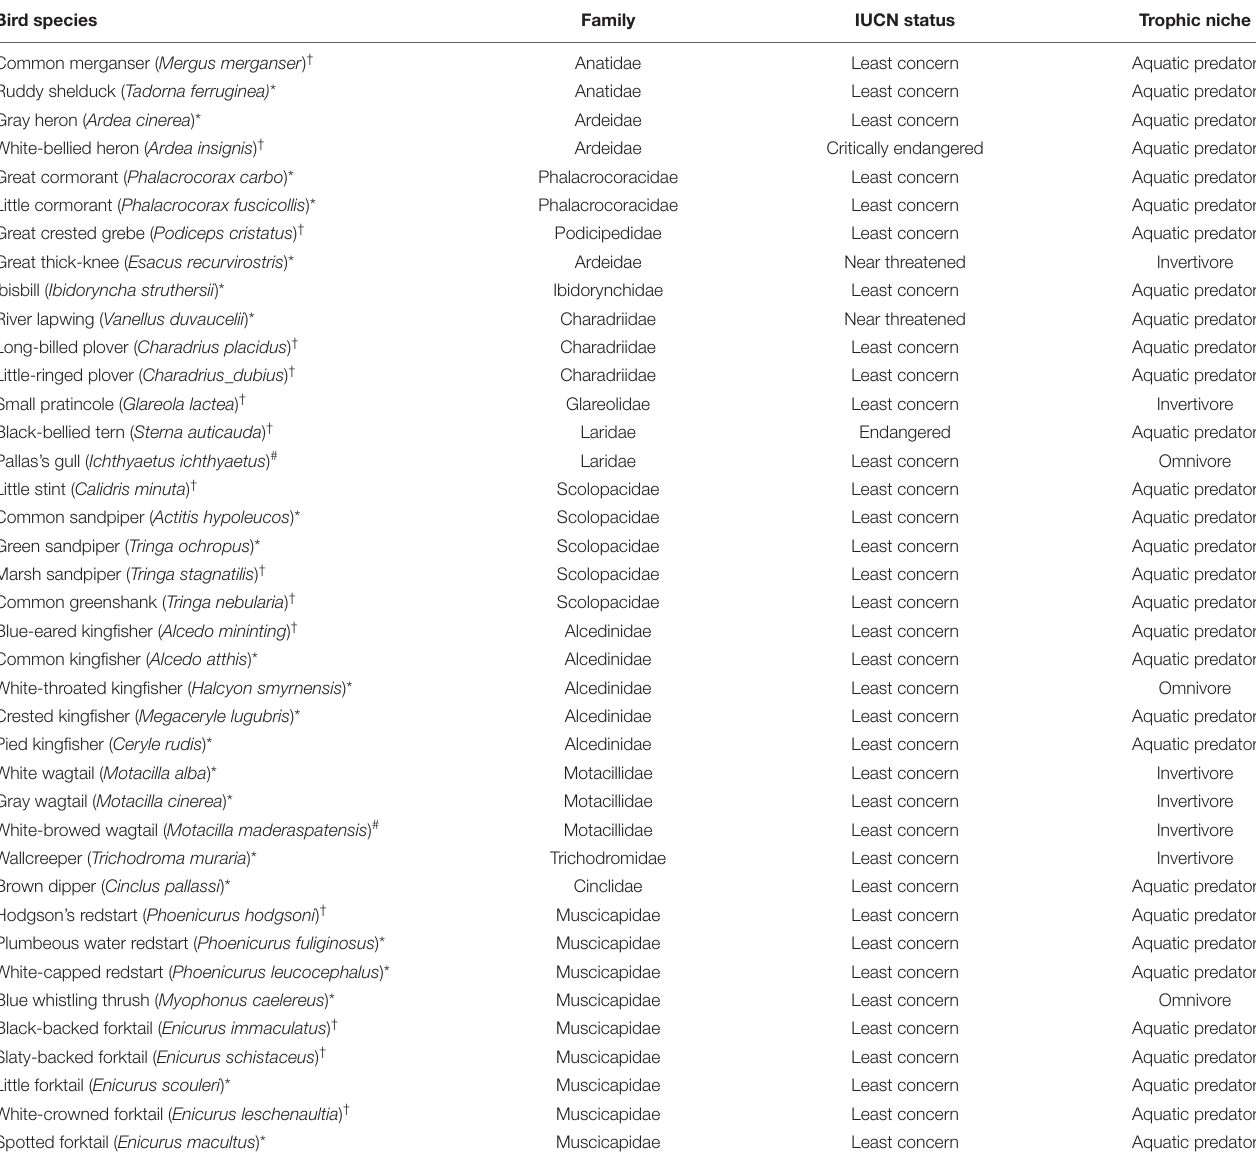
TABLE 1 | List of bird species recorded during field surveys in E and W Himalaya with their family, IUCN conservation status and trophic niche as classified by Pigot et al. (2020). Bird